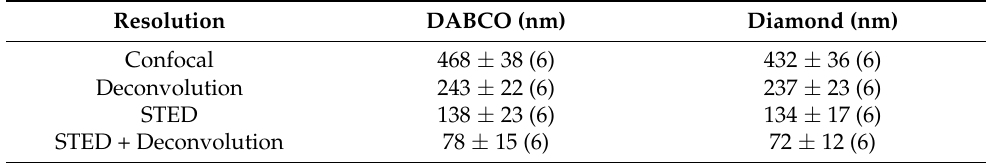
Table 3. Mean maximal achieved resolution in confocal, deconvolution, STED, and STED + deconvo- lution images after applying secondary STAR635P anti-Topo II antibodies in different embedding media (DABCO and Diamond). The number of measured chromosomes is in